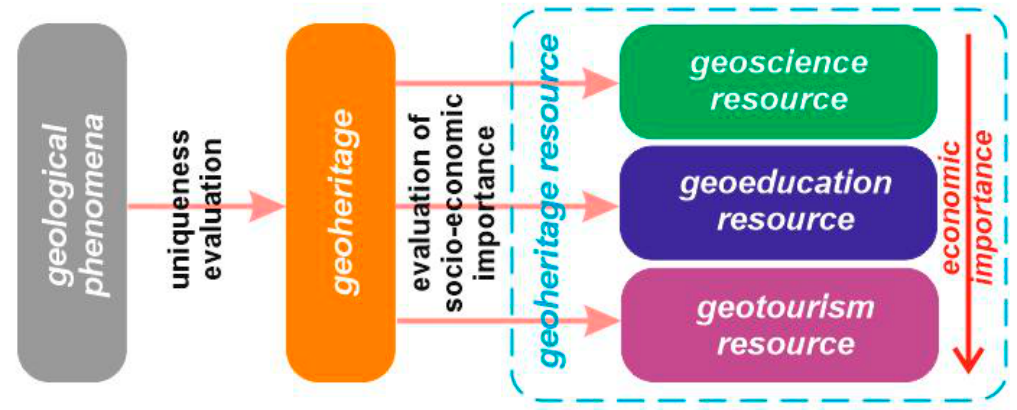
Figure 1. Basic processes and components of geoheritage resource evaluation.